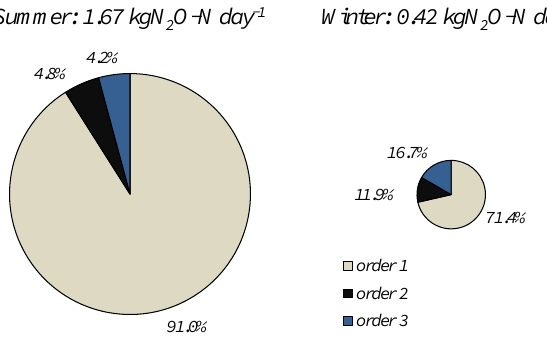
Fig. 5. Distribution of the daily N 2 O emissions of the Orgeval drainage network, as a function of stream order for a winter and a summer